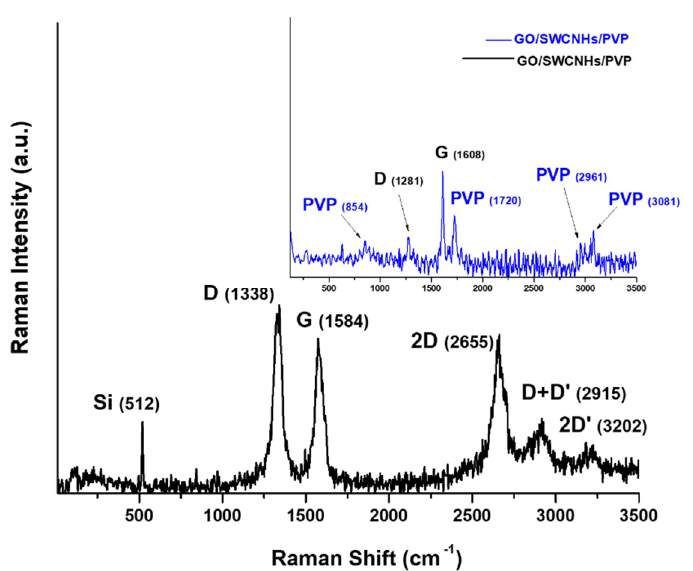
Figure 9. Raman spectra of solid-state films of GO/CNHox/PVP 1/1/1 (mass ratio) deposited on